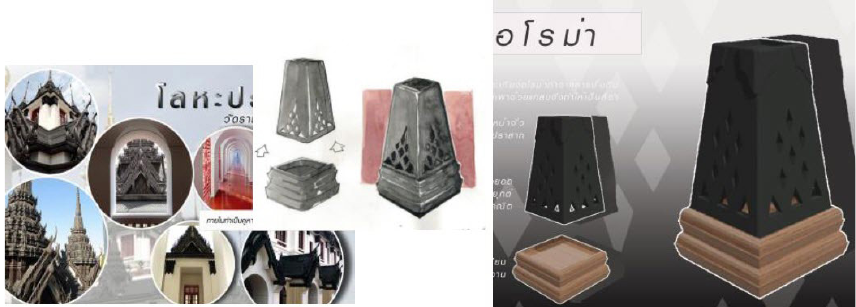
Figure 3. Group 3 design work inspired by Wat Ratchanatdaram (source: created by author) Group